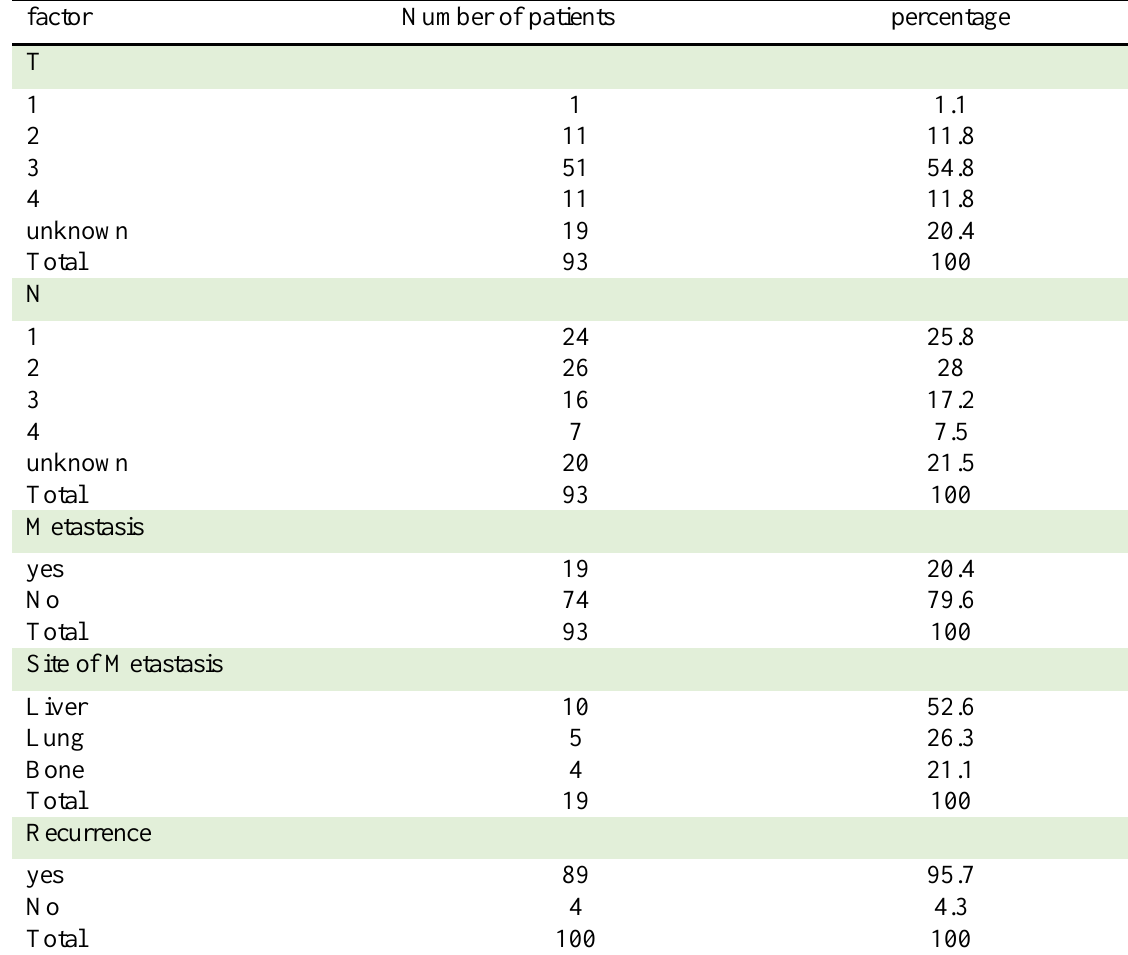
Table 1 : distribution of stages of tumors, lymph node involvement, different sites of distant metastasis, and tumor